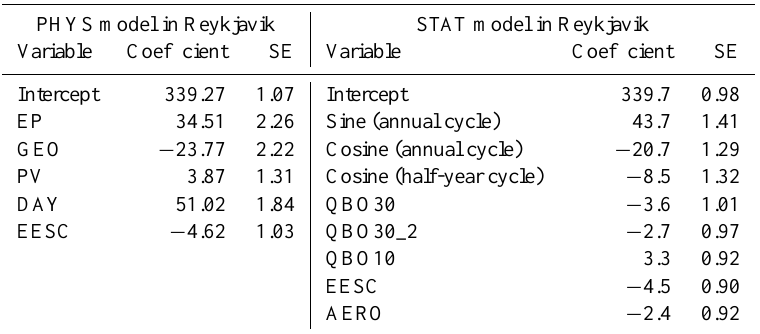
Figure 11. Ozone recovery rates based on EESC regression estimates (upper plots) or the piecewise linear function regression estimates (lower plots) using the PHYS model. Note that the color bar for the upper plots ranges from − 1 to 1DUyr − 1 , whereas for the lower plots the color bar ranges from − 2 to 2DUyr − 1 . Table 4. Regression coefficients and standard errors of regressions in Reykjavik, Iceland. QBO10 and QBO30 represent the QBO index at 10 and at 30hPa,